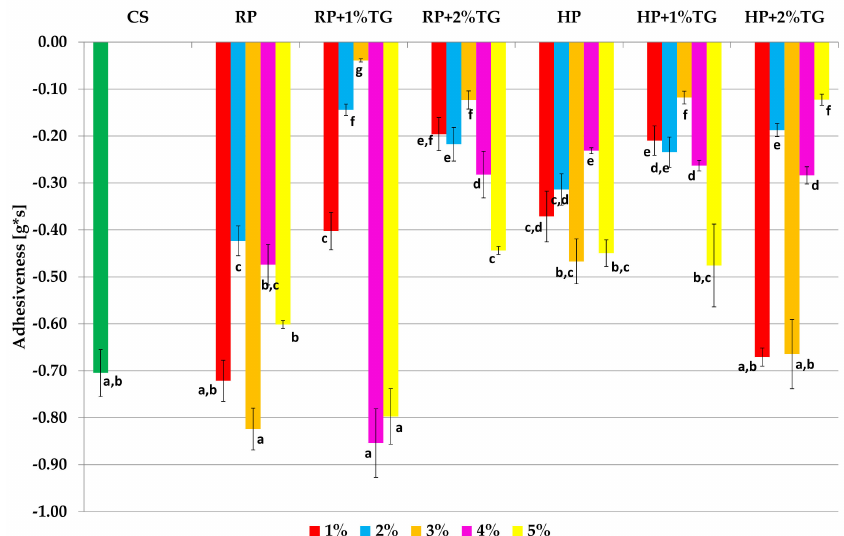
Figure 7. Average adhesiveness values of hydrated instant noodles with the addition of rice protein, hemp protein and TGase (CS—control sample, RP—rice protein, RP+1%TG—rice protein with 1% TGase, RP+2%TG—rice protein with 2% TGase, HP—hemp protein, HP+1%TG—hemp protein with 1% TGase, HP+2%TG—hemp protein with 2% TGase). Columns correspond to various additions of rice protein. Mean values denoted by different letters ( a – g ) represent statistically significant differences between variables ( p <